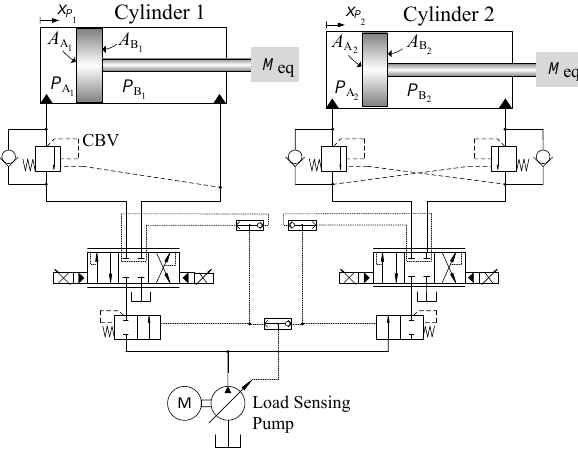
Figure 10: Knuckle Boom Crane hydraulic circuit from Donkov et al.